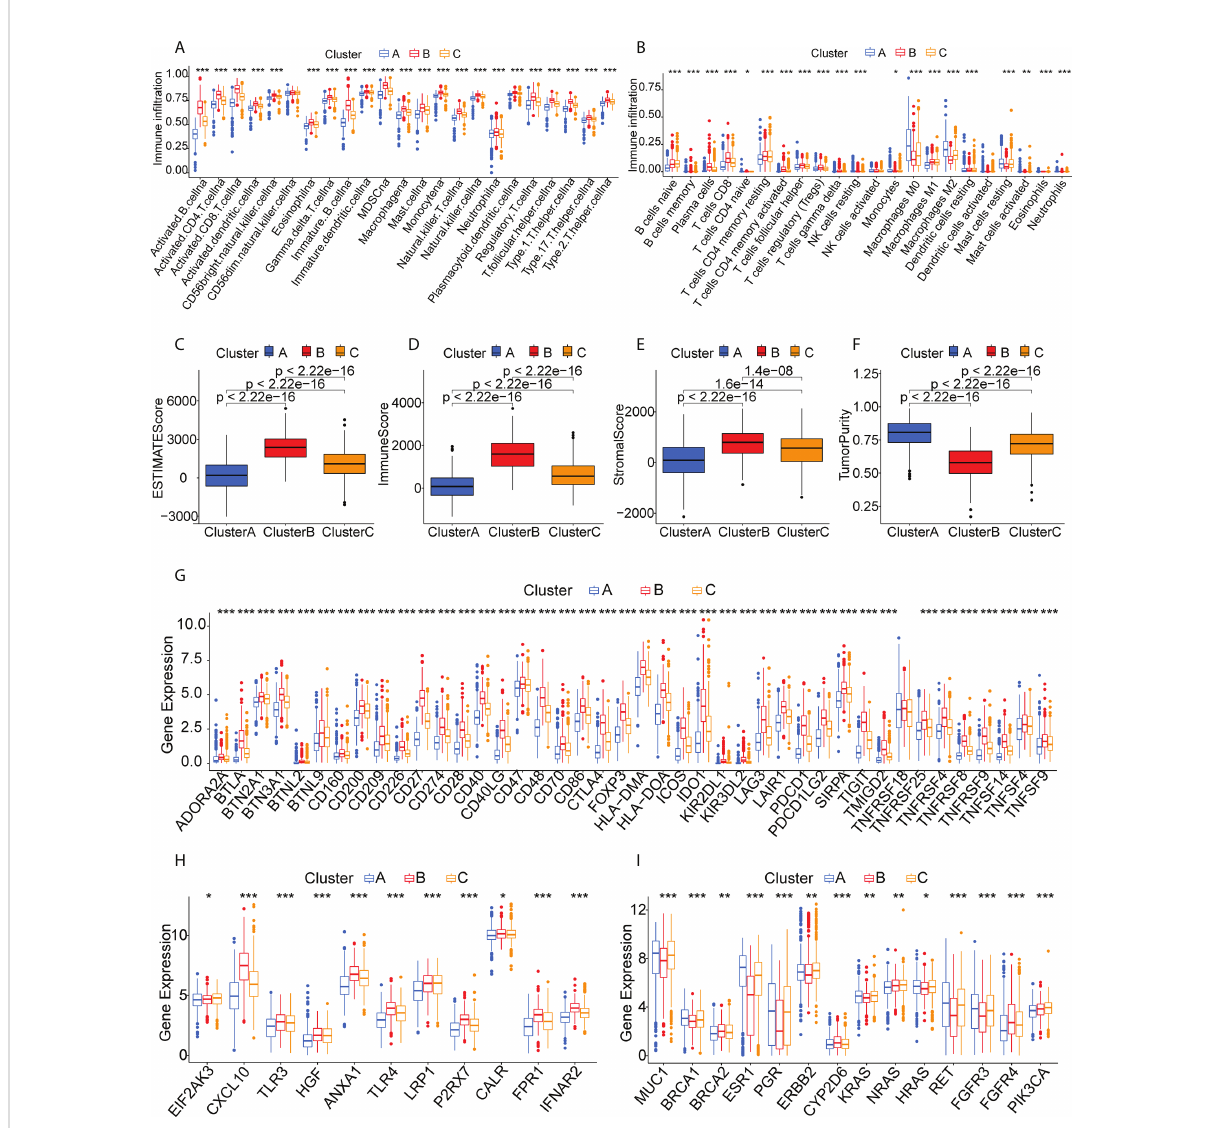
FIGURE 4 Immune cell in fi ltration in the different clusters. (A) Boxplot showing immune cell in fi ltration, shown by ssGSEA enrichment. (B) Boxplot showing immune cell in fi ltration, shown by CIBERSORT. (C-F) Immune-stromal scores and tumor purity of patients in the clusters, determined by ESTIMATE. (G) Expression of immune checkpoints in the clusters. (H) Expression of immunogenic cell death modulators in the clusters. (I) Comparison of breast cancer biomarkers between the immune clusters. "*" represents that p-value <0.05; "**" represents that p-value <0.01, and "***" represents that p-value